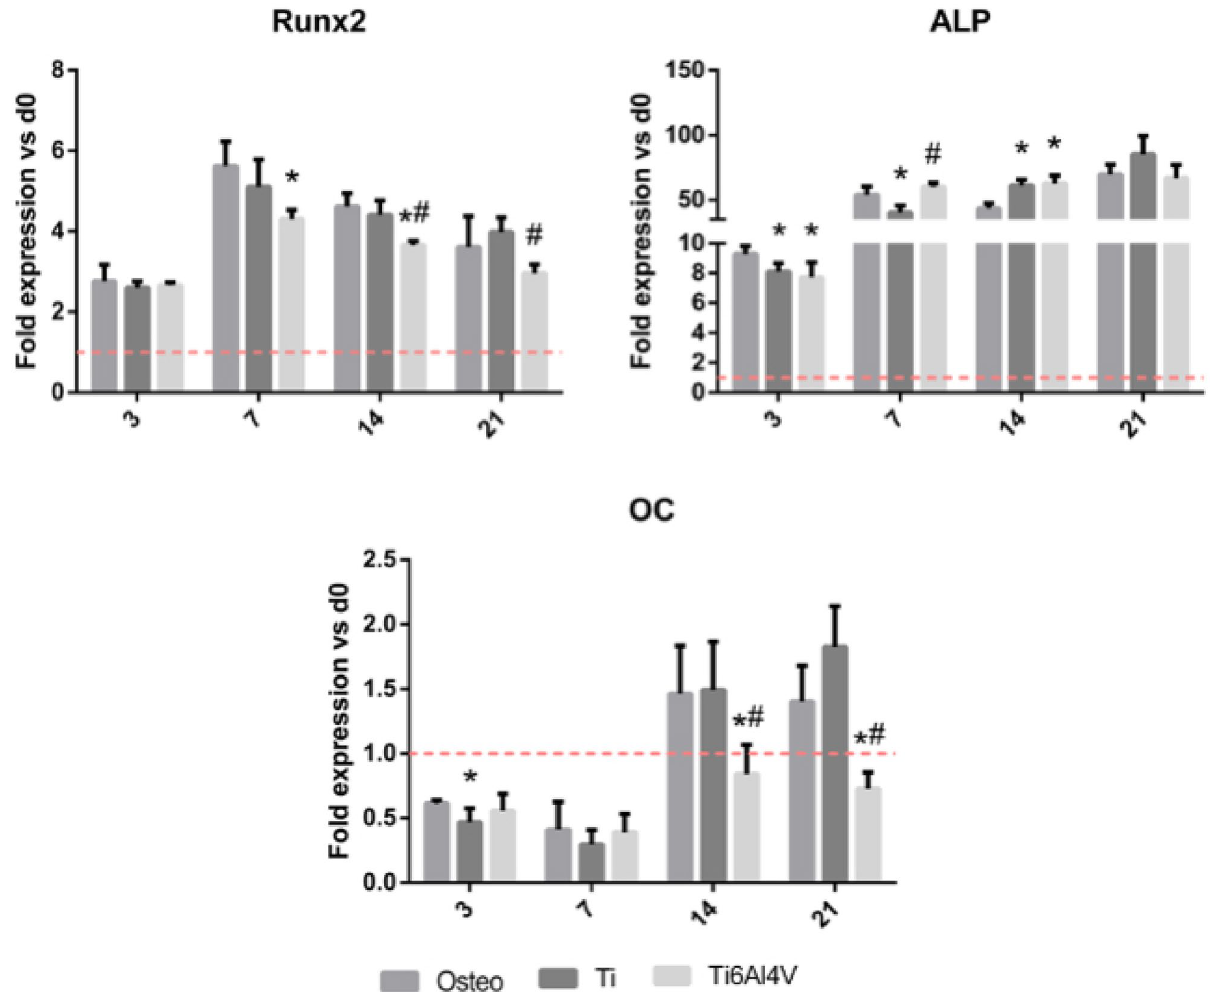
Figure 5. Effect of stimulation with Ti and Ti6Al4V alloy extracts upon gene expression of osteogenic markers Runx2, ALP and OC in cultured human bone marrow-derived mesenchymal stem cells (BM-MSCs). Statistically significant differences ( p < 0.05) are represented with * when comparison was made versus osteogenic medium (Osteo) and with the symbol # when comparison was made versus